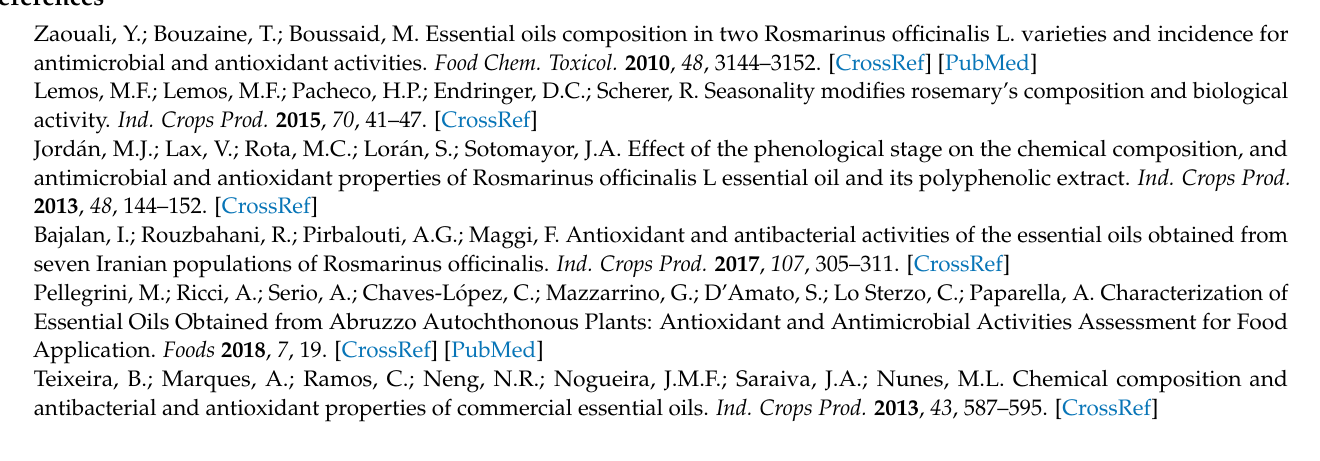
Table S1: Retention time, ion fragments, and identification methods for rosemary essential